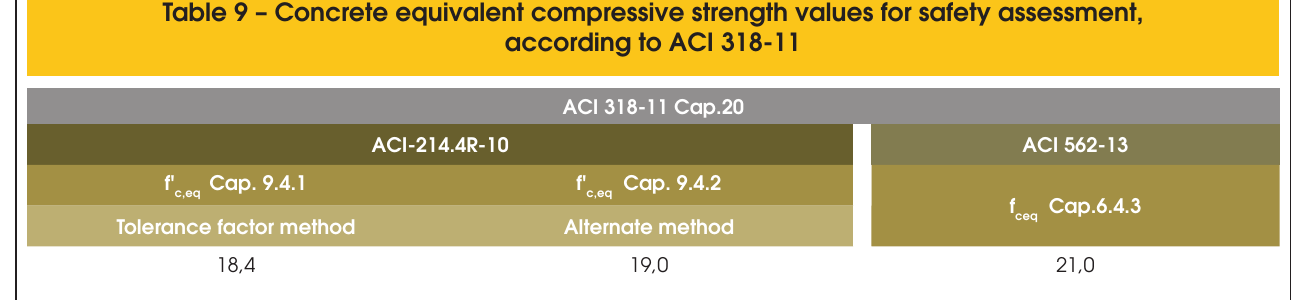
for safety assesment, ck